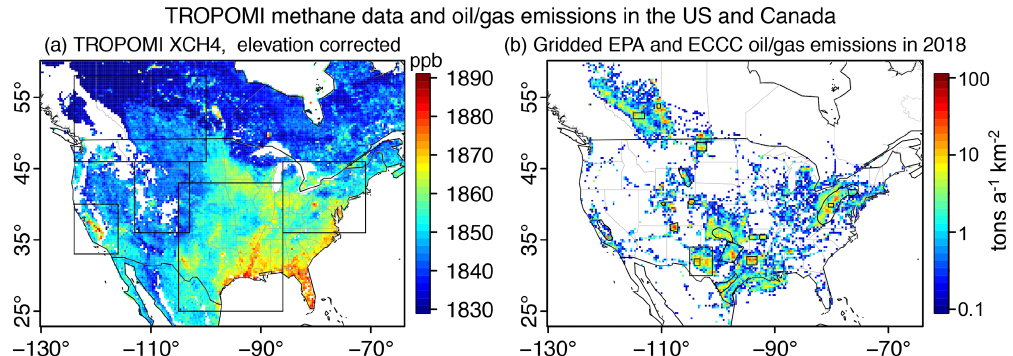
Figure 1. TROPOMI methane observations and prior estimates of oil and natural gas emissions in the US and Canada. (a) TROPOMI satellite observations of the column-averaged dry methane mixing ratio (XCH 4 ) averaged from May 2018 to February 2020, mapped to 0 . 25 × 0 . 3125 ◦ resolution and corrected for surface topography as 7ppbkm − 1 (Kort et al., 2014). This elevation correction is only for visualization. We conduct the inversions for the five rectangular domains shown in black that account for over 98% of O / G emissions in the continental US and Canada. (b) Gridded national inventory emissions from the oil and natural gas sectors in the US and Canada in 2018 used as prior estimates in our inversion of TROPOMI observations. Grid cells with emission fluxes < 0 . 1 metric tona − 1 km − 2 are shown in white. The boundaries of the 19 major O / G basins are shown on the map, and the names of these basins can be found in Fig.